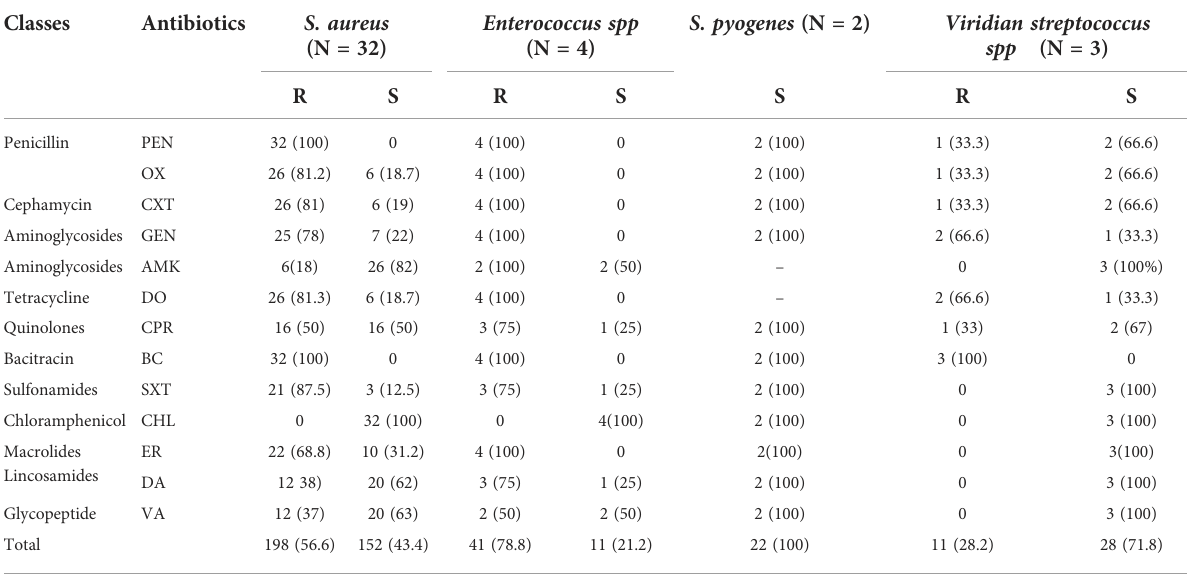
TABLE 4 Antimicrobial susceptibility patterns of isolated gram-positive bacteria. Antimicrobial tested Susceptibility and resistance pattern of isolated Gram-positive bacteria N